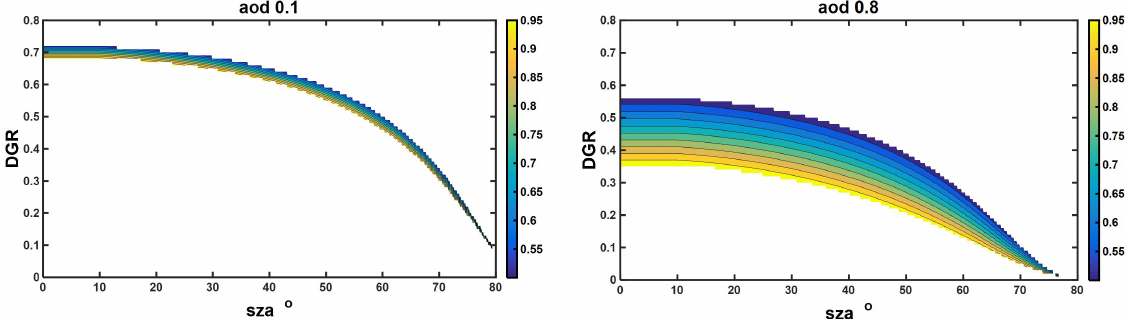
Figure 6. LUT of direct to global ratio at 368nm, as calculated for AOD 0.1 (left) and 0.8 (right) with respect to SZA ( g = 0.7); color bar represents the SSA values.